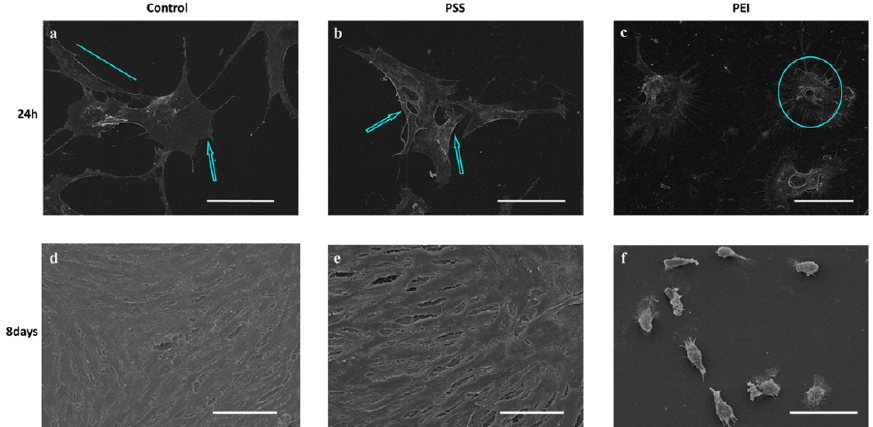
Figure 1. Scanning electron micrographs (SEM) of MSCs grown for 24 h and 8 days on glass ( a , d ), PSS-ended ( b , e ), and PEI-ended ( c , f ) slides. Scale bar: control and PSS, 80 μ m; PEI, 40 μ m. Cyan line, arrows, and circle show cell morphology on three different substrates.